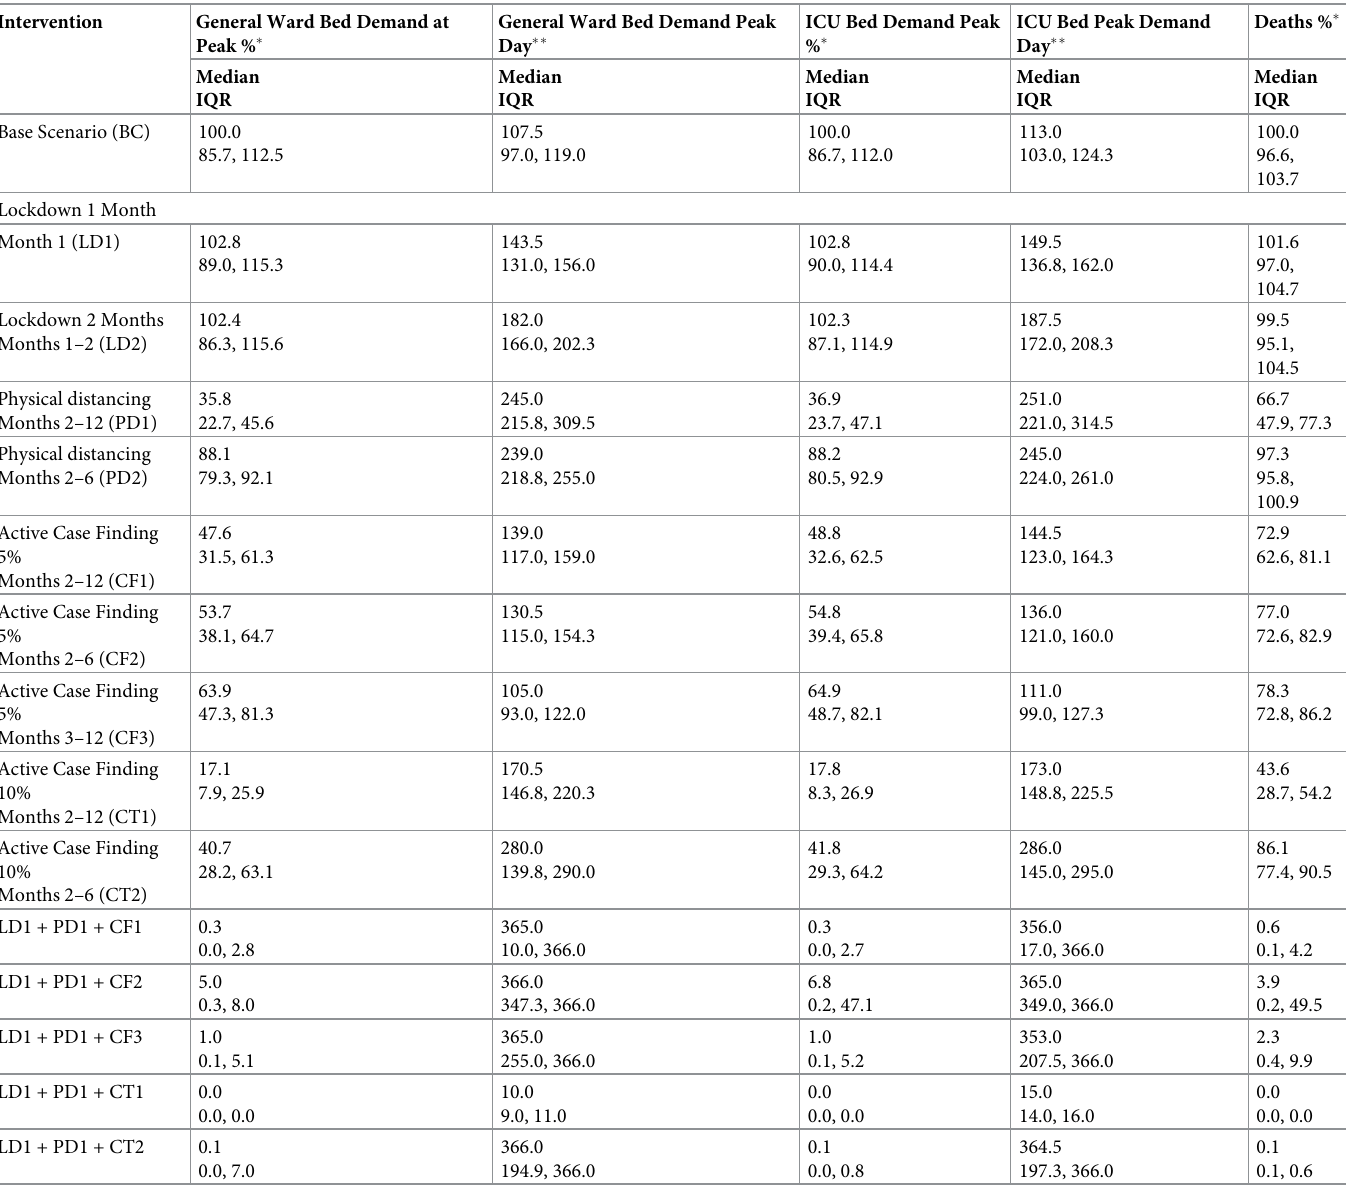
Table 3. Modeled interventions against COVID-19 and their